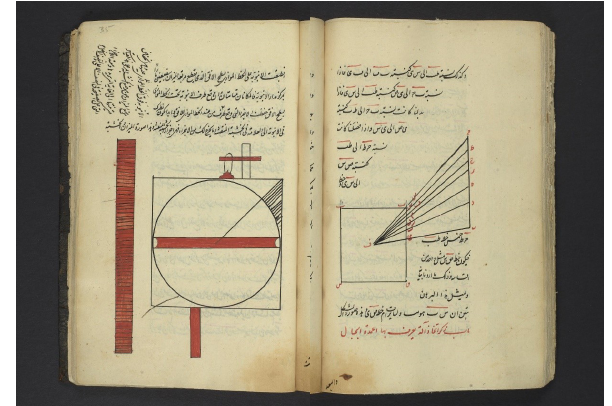
Figure 4. Illustrations of surveyor’s level apparatus invented by Karaji and the proof and description on its application. Dia- grams f26r and f29r from Karaji (1675). Permanent link: http://hdl. library.upenn.edu/1017/d/medren/9948256513503681 (last access: 29 July 2019).